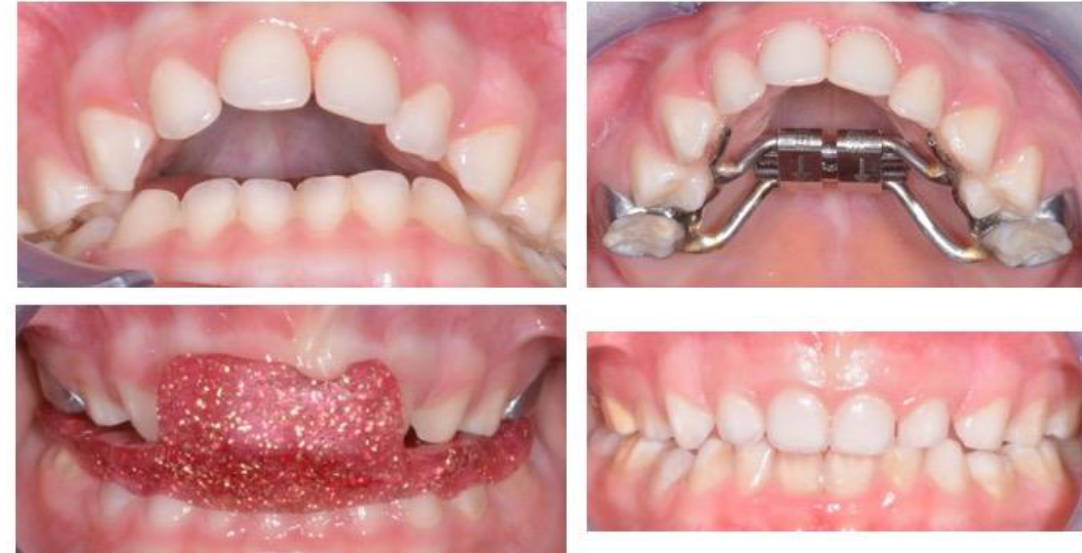
Figure 3. A child affected by rAOM, recurrent impacted cerumen, and OSAHS. A severe retruded bite, overjet, and ogival palate are present. The oral appliance is adaptable to coexist with a maxillary expansion device.